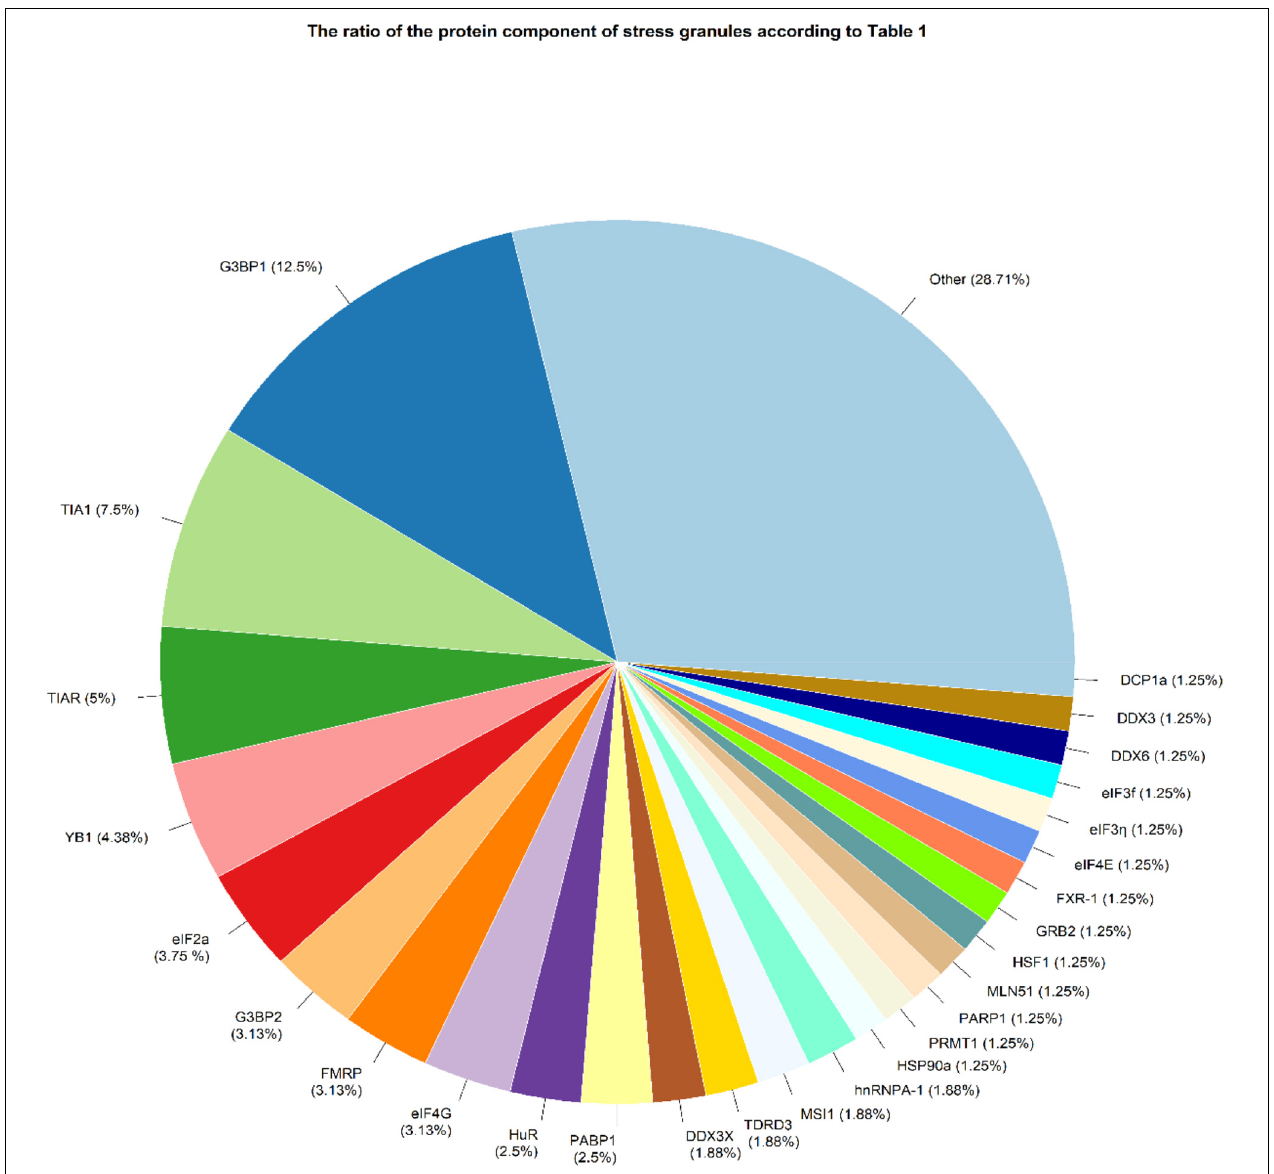
FIGURE 3 | SGs protein components were examined in studies. OTHER refers to proteins that have been considered only once in all studies, including ANG, ASF/SF2, astrin, ATF-4, ATXN2L, CAPRIN1, CIRBP, CRNDEP (peptide), eIF3A, eIF4A1, eIF4D, EWS, FUS, Gal-3, GRP78, hnRNPA/B, hnRNPk, hnRNP-L,